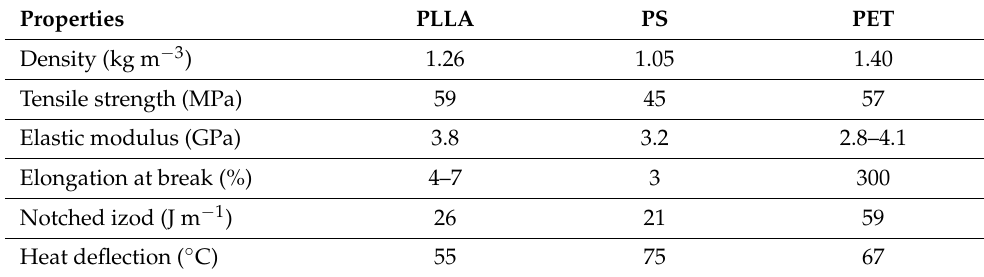
Table 1. Properties of PLA, PS, and